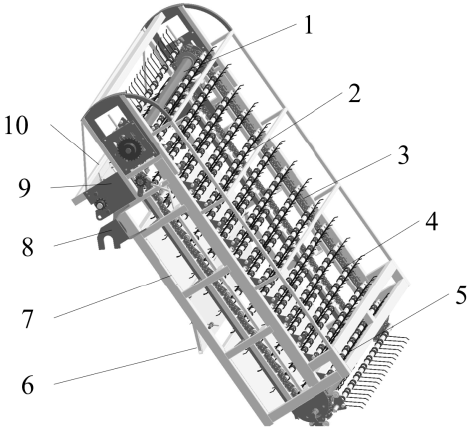
Figure 1. The residual film recycling machine: 1. Traction frame; 2. Power transmission system; 3. Straw crushing device; 4. Mulch storage and pushing out device; 5. Machine frame; 6. Wheels; 7. Hook-and-tooth chain rail type residual film picking device.